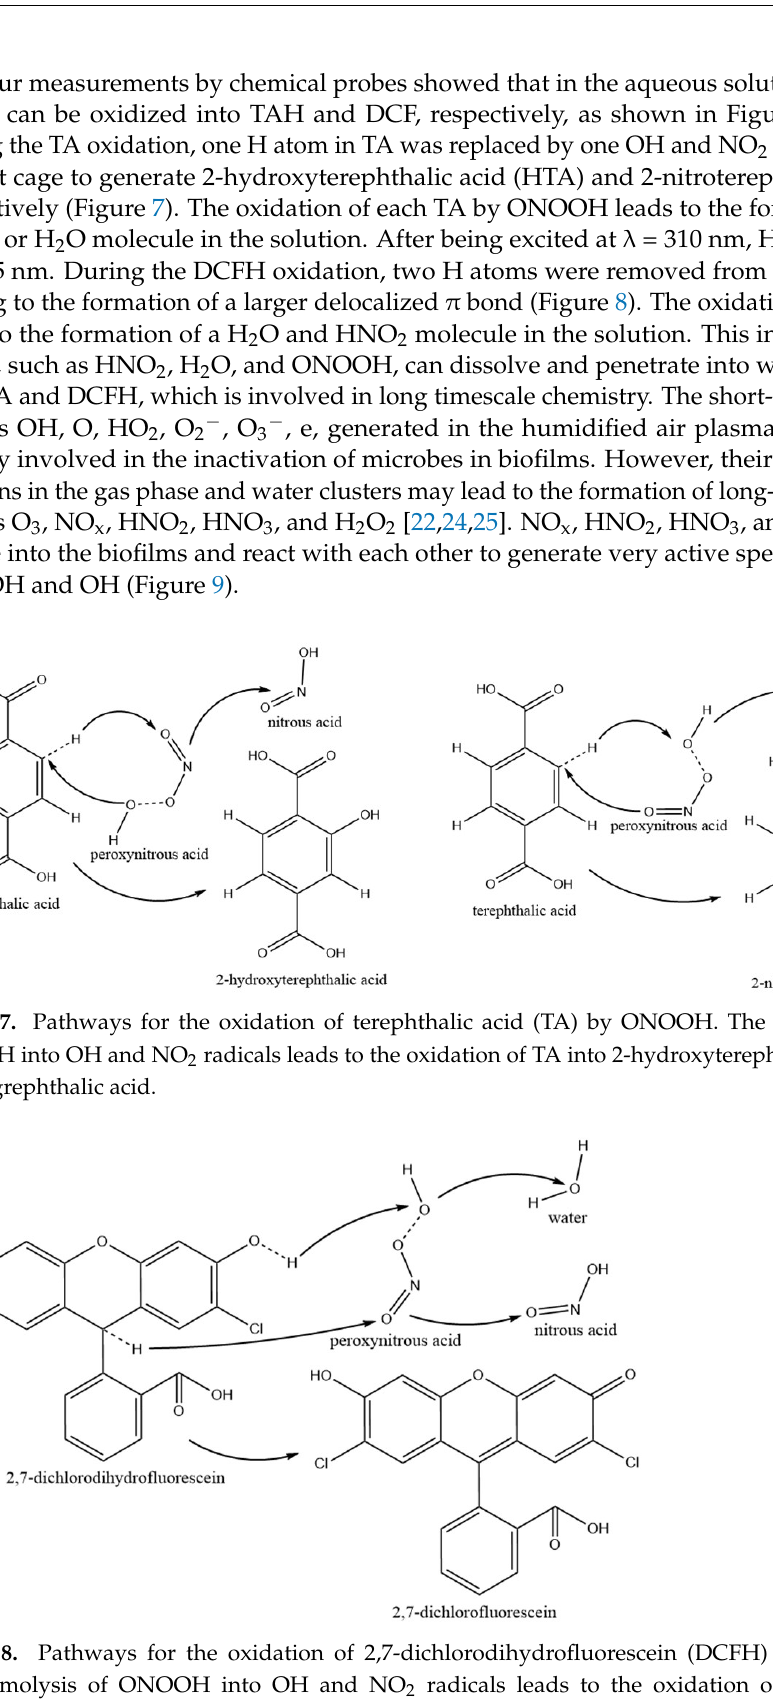
Figure 9. Mechanism for the inactivation of microbes in the biofilms by humidified air plasma. The humidified air plasma generates the long-lived RONS in the gas phase, such as Y(H 2 O) n , O 3 , NO, NO 2 , N 2 O 5 , N 2 O 4 , H 2 O 2 , and HNO 2 . These long-lived RONS diffuse into the biofilms and react with each other to generate very active species, such as OH and ONOOH, leading to the oxidation and inactivation of microbes in the biofilms. The reaction of HNO 2 with H 2 O 2 , leading to the formation of ONOOH, is affected by the pH value of aqueous solutions [7]. At pH 3.3, the rate of ONOOH formation was in the range of 10 − 8 –10 − 9 M s − 1 . The ONOOH was shown to oxidize phenol into its nitrated and nitrosylated products and significantly participates in the antibacterial properties of PAW. One geminated NO 2 and OH pair in the [ONO ⋅⋅⋅ OH] cage could simultaneously at- tack one TA or DCFH in the aqueous solution, leading to the synergistic oxidation reaction